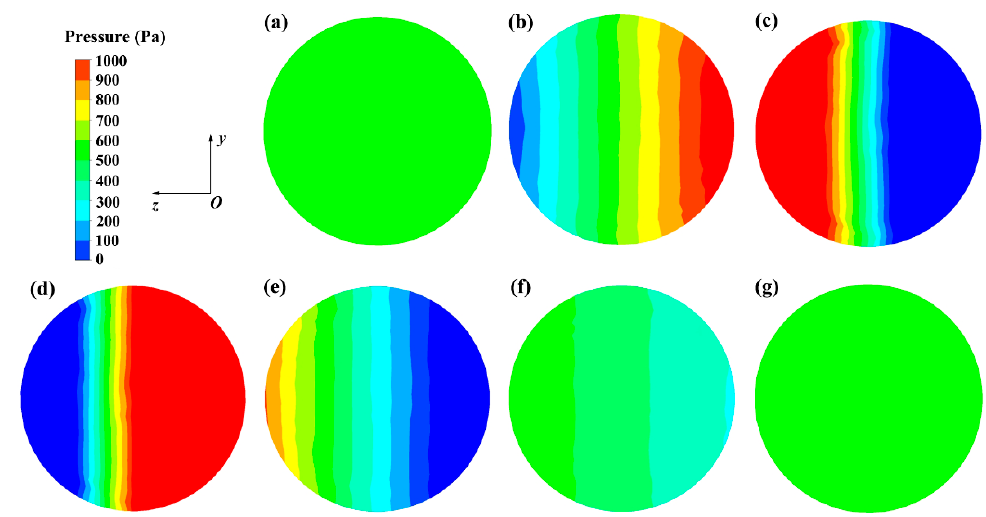
Figure 10. Contours of the pressure distribution of liquid hydrogen on the plane of y = 0 ( a – g corre- sponding to the time of 0, 0.01 s, 0.02 s, 0.03 s, 0.04 s, 0.2 s and 0.3 s, respectively).